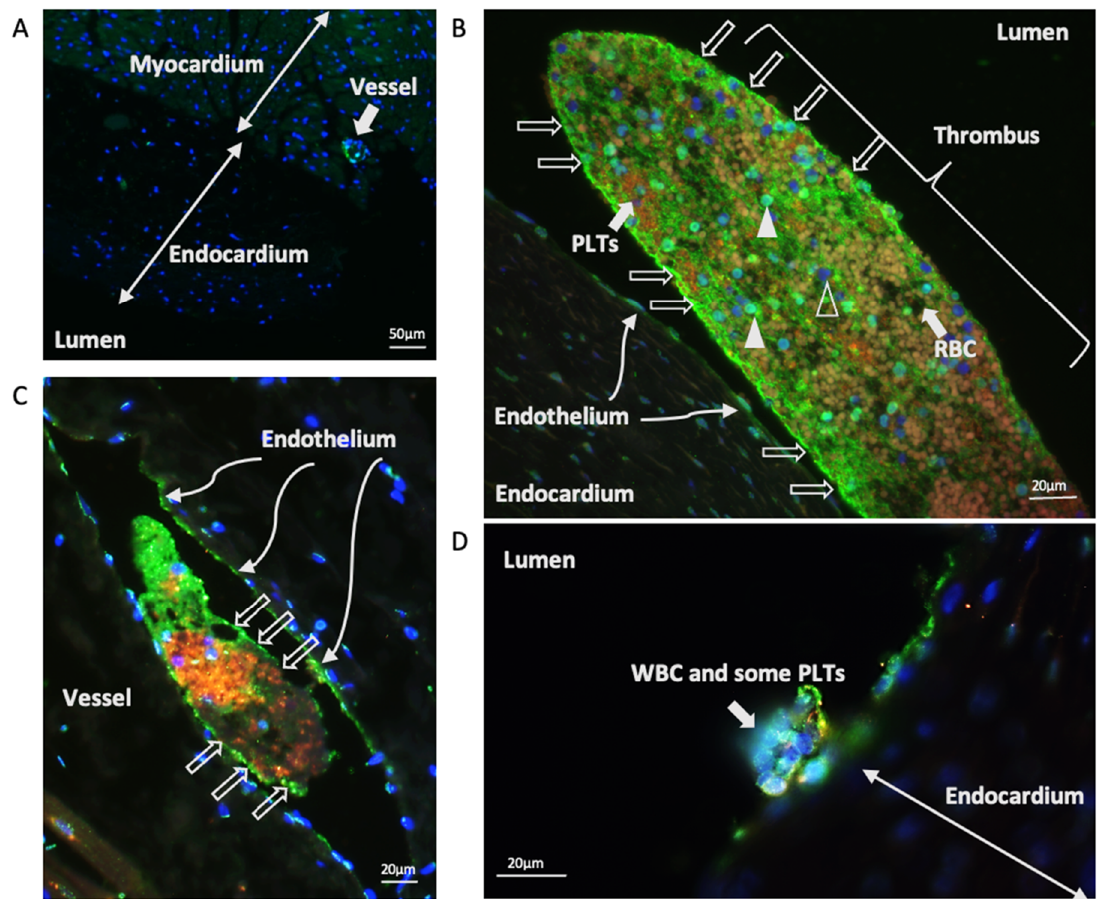
Figure 1. Localisation of vWF in the LA samples. ( A ) vWF localised to the endothelium of a vessel (wide arrow) in a control cat where there was minimal immunostaining of vWF at the left atrial endocardium. 100 × magnification. ( B ) In this microthrombus from a cardiomyopathic cat with clinical signs, vWF appeared to form a scaffold outside (open arrows) and within the microthrombus. Red blood cells (RBC) were relatively fluorescence-lucent (thick arrow). vWF also localised to the leucocytes, (closed arrow heads) and platelets (PLTs) within the microthrombus. Some leucocytes did not immunostain for vWF (open arrow heads). Endocardial endothelial cells (thin arrows) also expressed vWF. ( C ) vWF localised to the endothelium of a vessel in a cat with cardiomyopathy and clinical signs. The intravascular microthrombus had vWF (green) encompassing the thrombus (open arrows) and contacting the vascular endothelium. Platelets and vWF co-localised in the centre of the microthrombus (orange, or yellow). ( D ) vWF (green), leucocytes, or WBC (blue) and some platelets (orange or yellow) attached on the endocardium from a cardiomyopathic cat with clinical signs. 400× magnification.